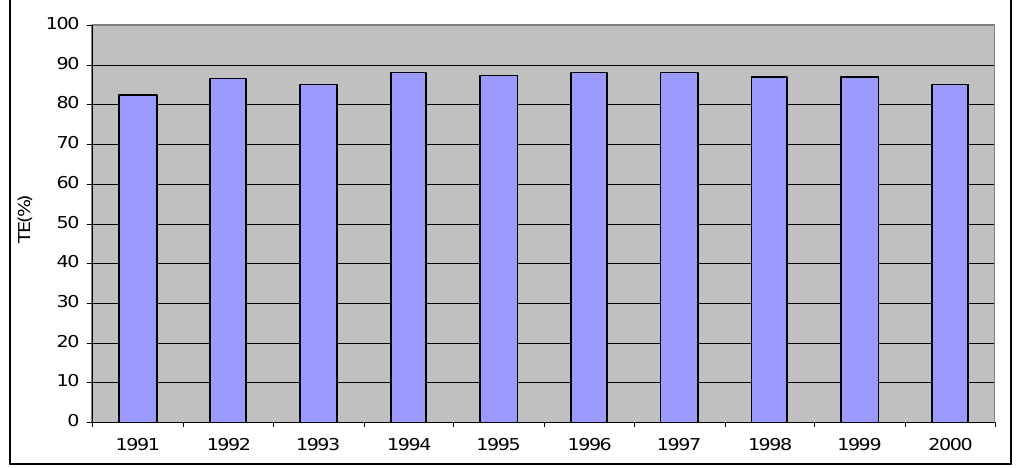
Figure 2. Average Annual Technical Efficiency (%)